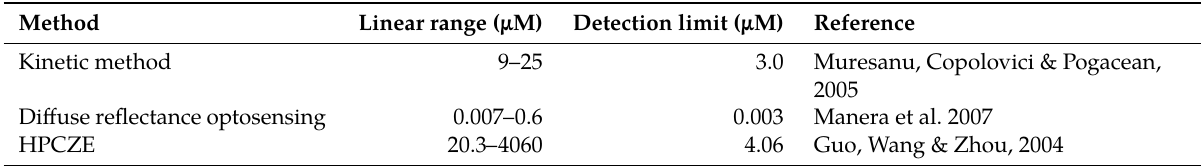
Table 2: Other p -NP determination methods.